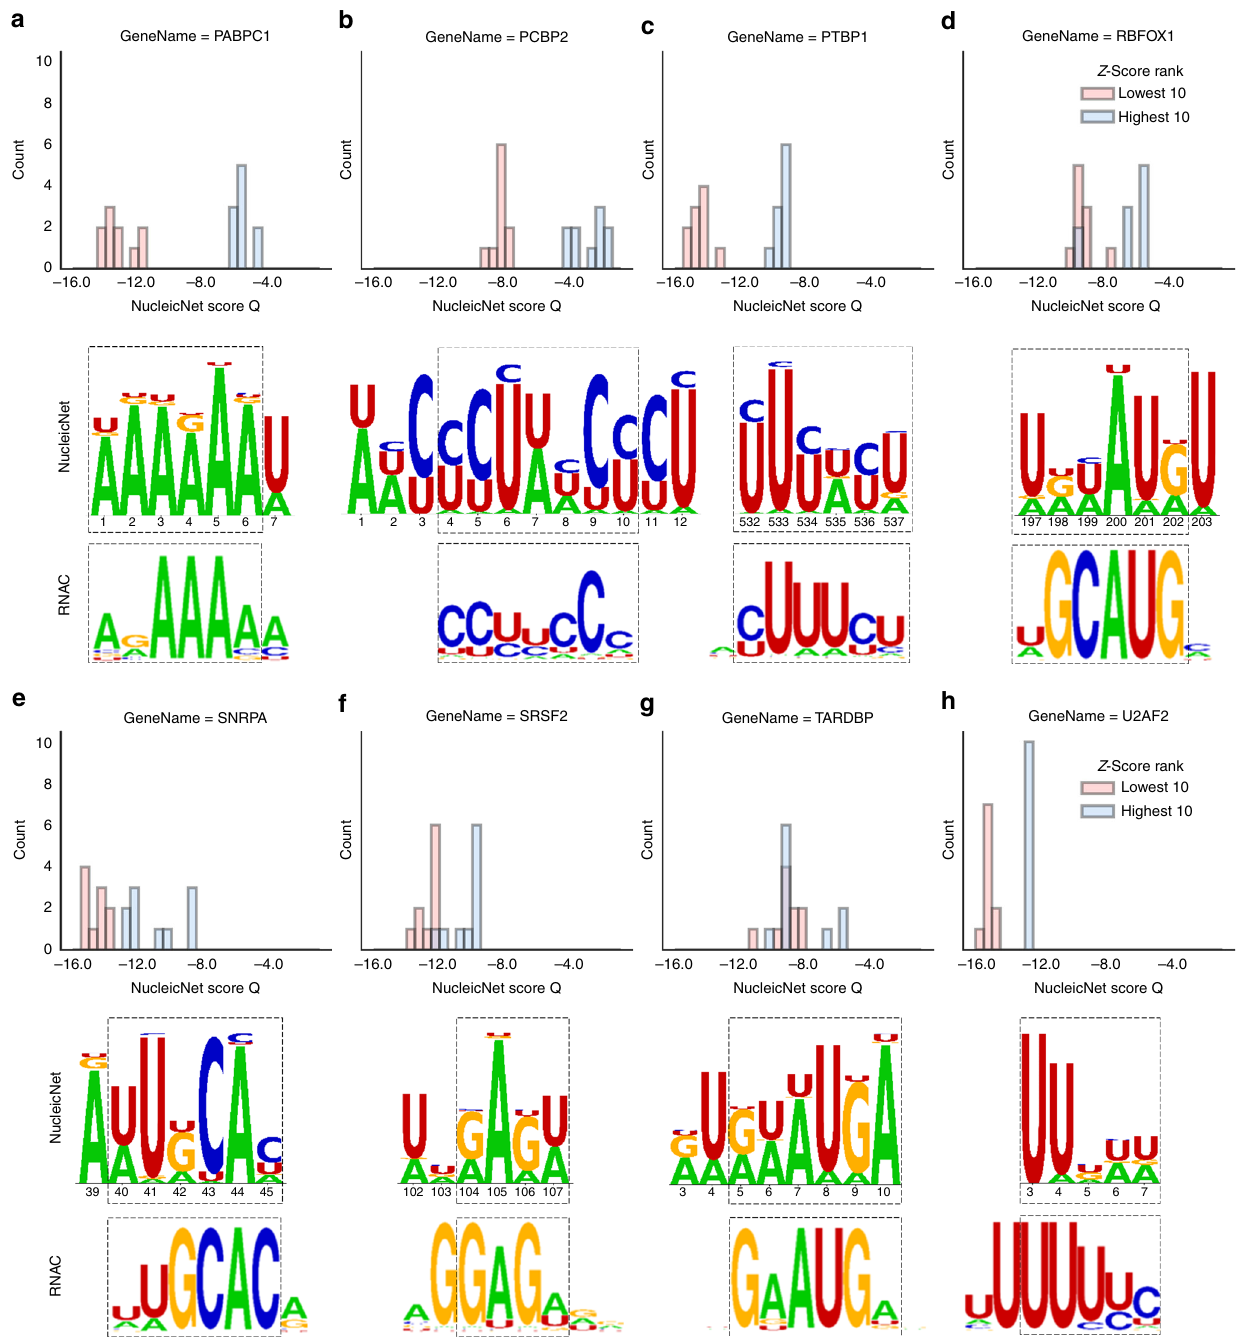
Fig. 4 Comparing scores and logo diagrams of NucleicNet with those obtained from RNAcompete (RNAC) assay. a PABPC1, b PCBP2, c PTBP1, d RBFOX1, e SNRPA, f SRSF2, g TARDBP, and h U2AF2. Upper panel: we show that the NucleicNet score is capable of differentiating top and bottom 10 sequences indicated by the RNAC Z-score. Lower panel: we compare sequence logos generated by NucleicNet with that by RNAC. Best matching sections of letters are highlighted with a dash (dsRBD). In Fig. 3, we indicate top predicted binding sites on panel, sequence logo diagrams were generated by averaging the these proteins for each binding class using our visualization NucleicNet score at the nucleobase locations on the long native module. In all cases, predictions were made on the protein RNA strand (Methods). In all cases, we show that NucleicNet has structure after removing RNAs from the ribonucleoprotein reproduced the detailed binding speci fi city captured by structural complex. These proteins and their homologs were all excluded biology experiments. from the training process. In Fig. 3 middle panel, we show that strong preference for nucleobases are mostly found at places where nucleotides interact explicitly with protein residues when superposed on a ribonucleoprotein structure. In Fig. 3 lower (PUF) family of RBPs are important post-transcriptional